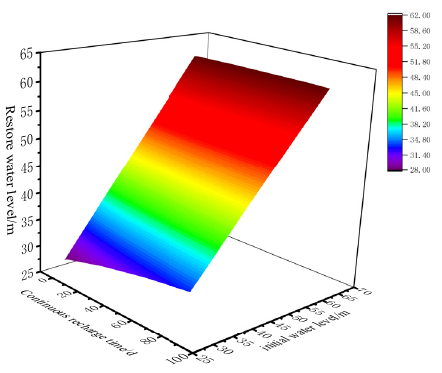
Figure 10. Recharge water to restore the water level.